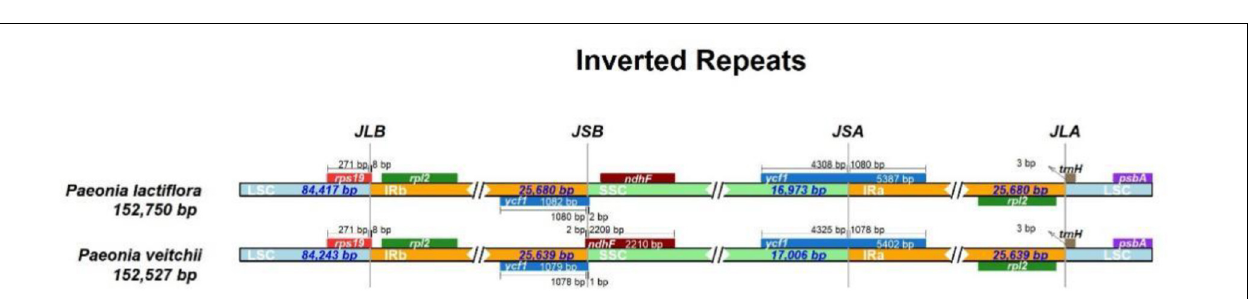
Frontiers in Plant Science |